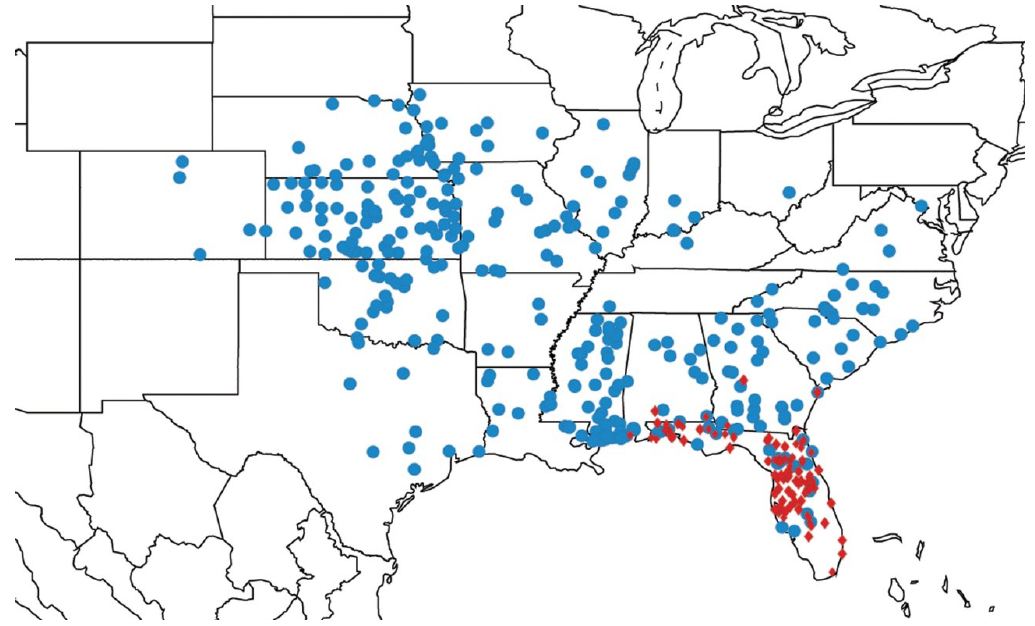
Figure 33. Distribution of Cicadetta calliope calliope (blue circles) and C. calliope floridensis (red